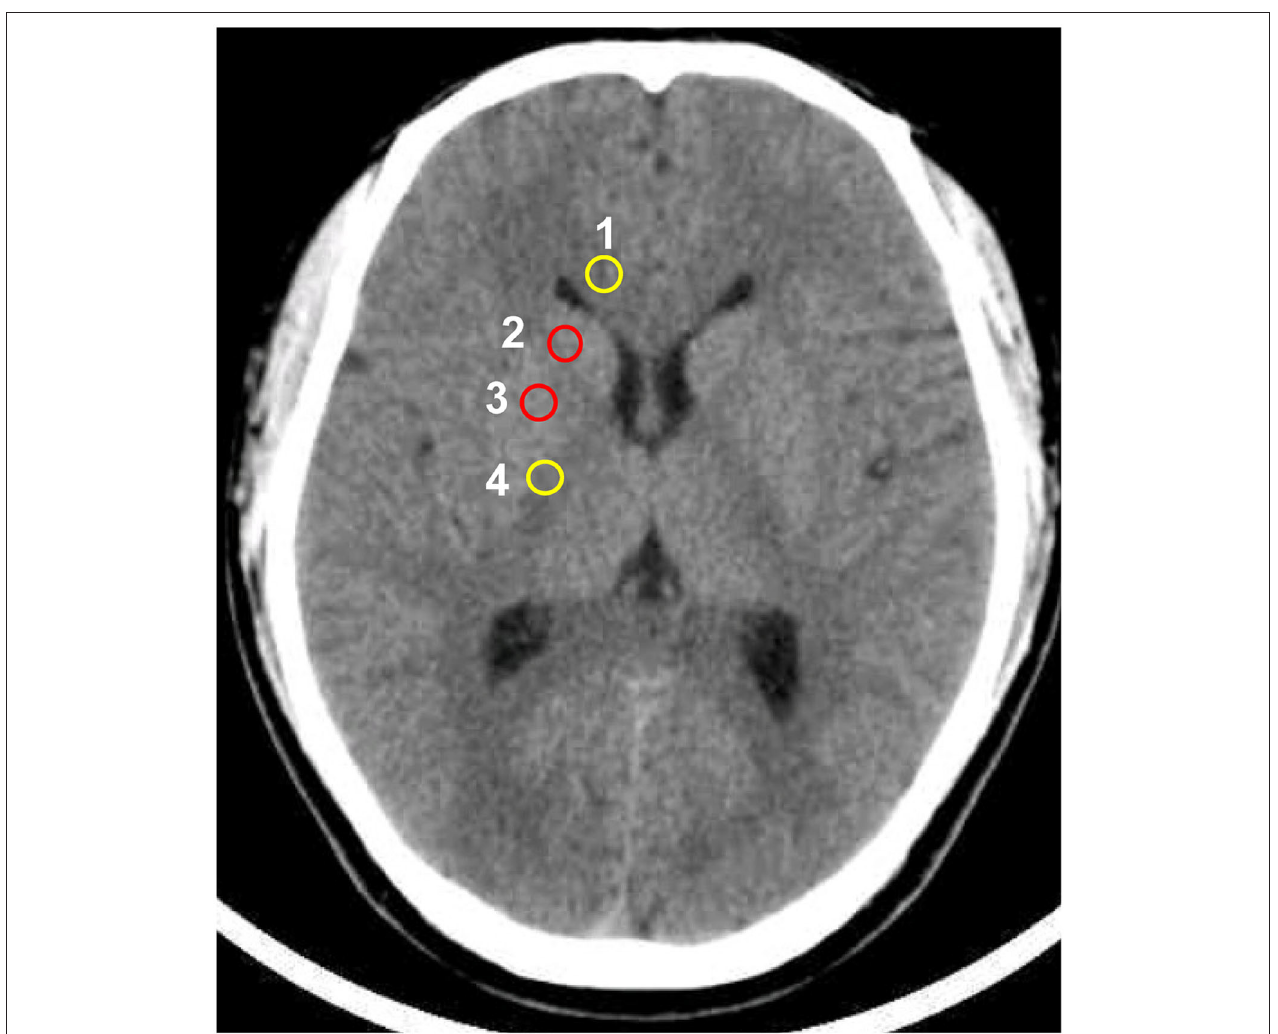
FIGURE 2 | Circular regions of interest drawn bilaterally in the following regions: 1 corpus callosum, 2 caudate nucleus, 3 putamen, 4 posterior limb of the internal